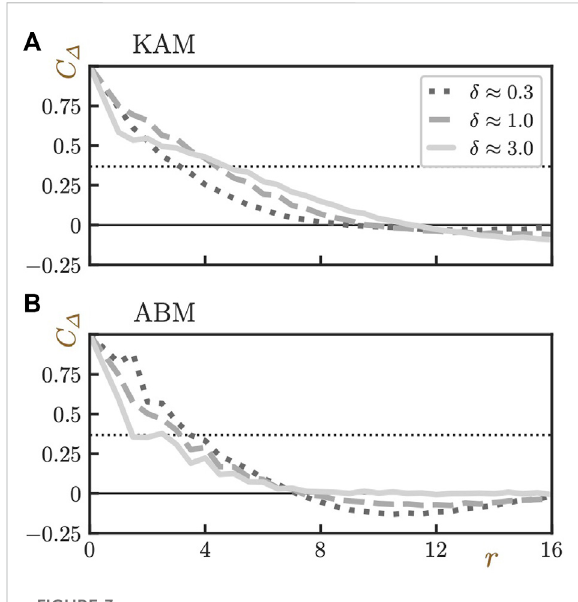
FIGURE 3 The spatial correlation function of the dynamic propensity Δ , C Δ , as a function of the distance from the reference particle r . Results for (A) KAM and (B) ABM systems. Different line styles distinguish different time scales as shown in the legend. The horizontal dotted lines depict C Δ = 1/ e .